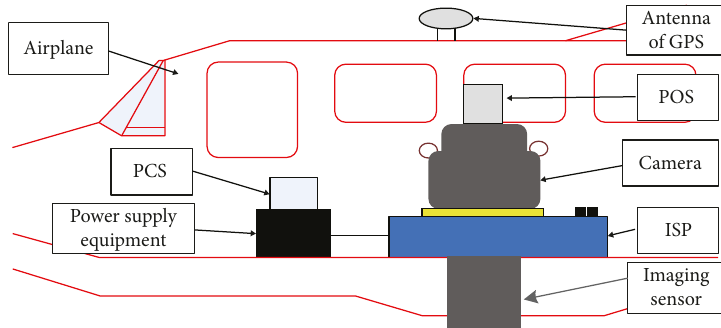
Figure 1: Schematic diagram of an aerial remote sensing